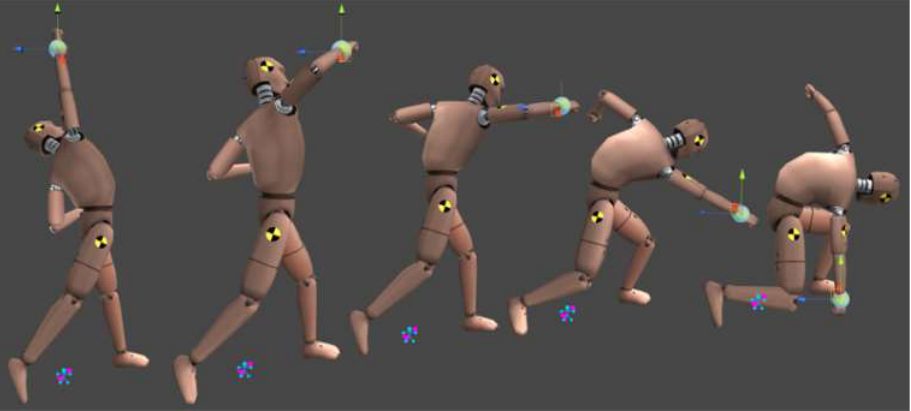
Figure 14. The position change of joints depending on the position change of the target.